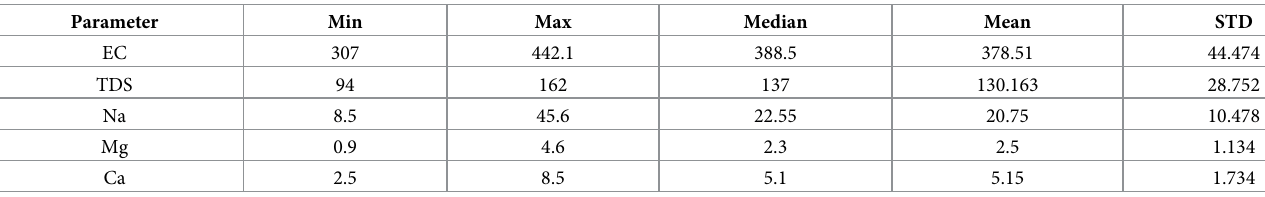
Table 9. Water quality characteristics from 1 m column depth effluent.